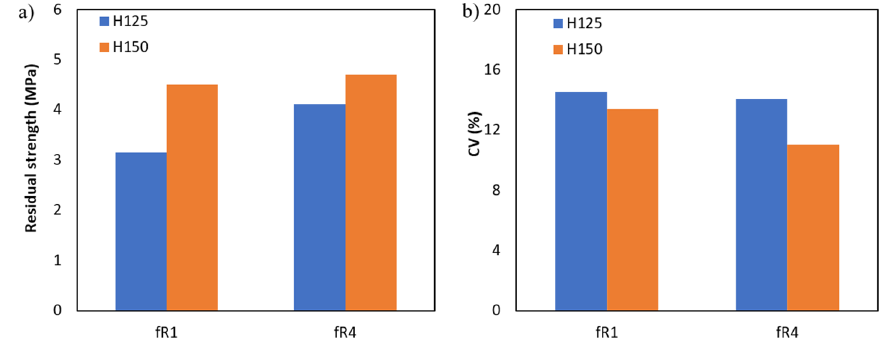
Figure 4 . Results for H125 and H150: a) average and b) CV for f R1 and f R4